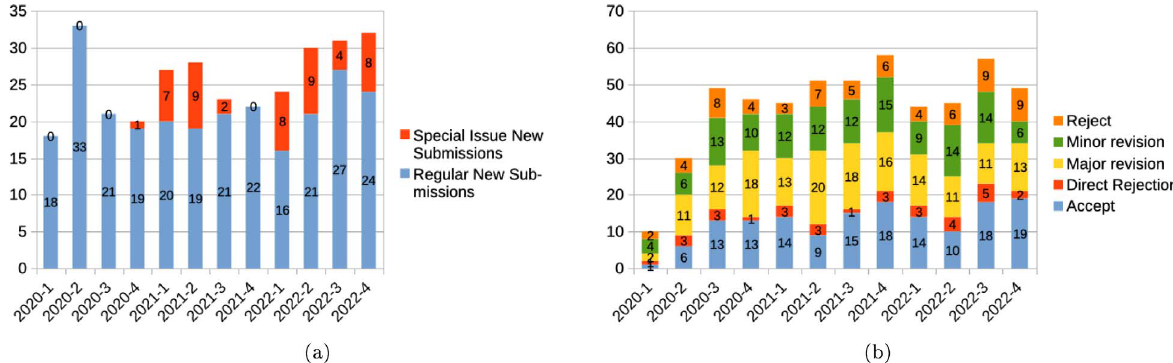
Figure 2. Regular submissions and submissions to special issues, and decision made by the editors. (a) Submissions; (b) Decisions of